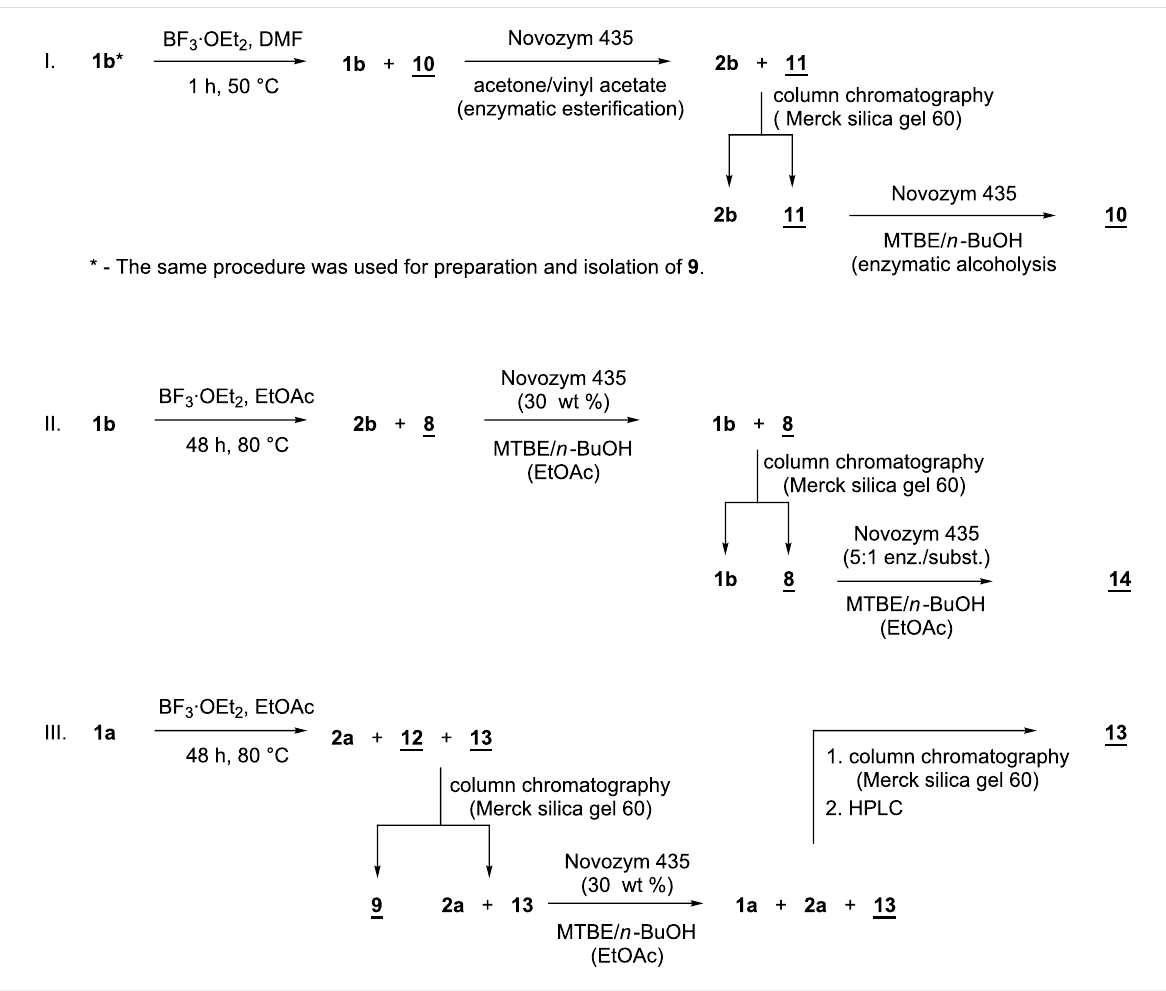
Scheme 4: Schematic flowchart of the procedures for the preparation and the isolation of cis -silybin isomers ( cis -isomers are underlined).